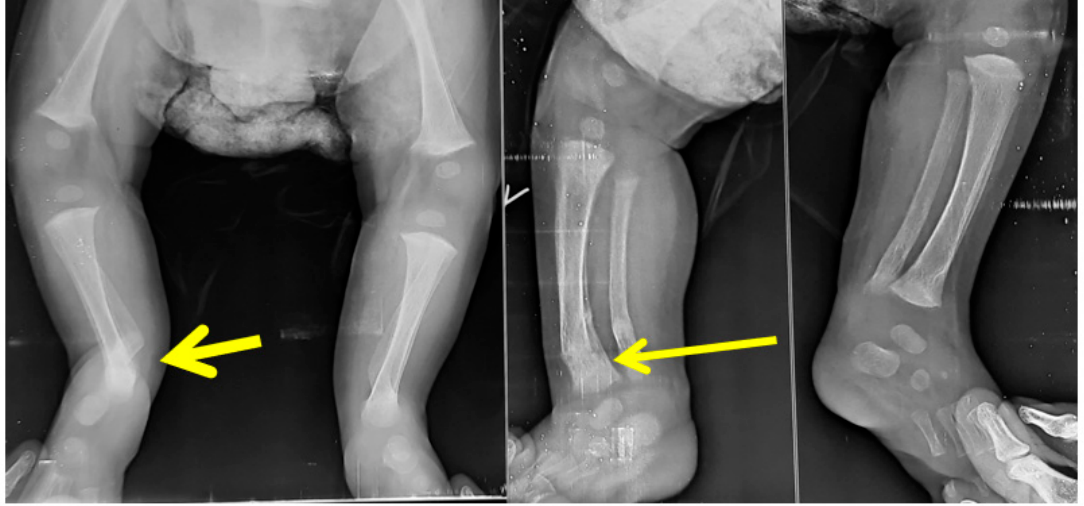
Figure 6. Radiographs showing fracture of the distal tibia metaphysis (pointed by the arrow) during Ponseti serial casting.